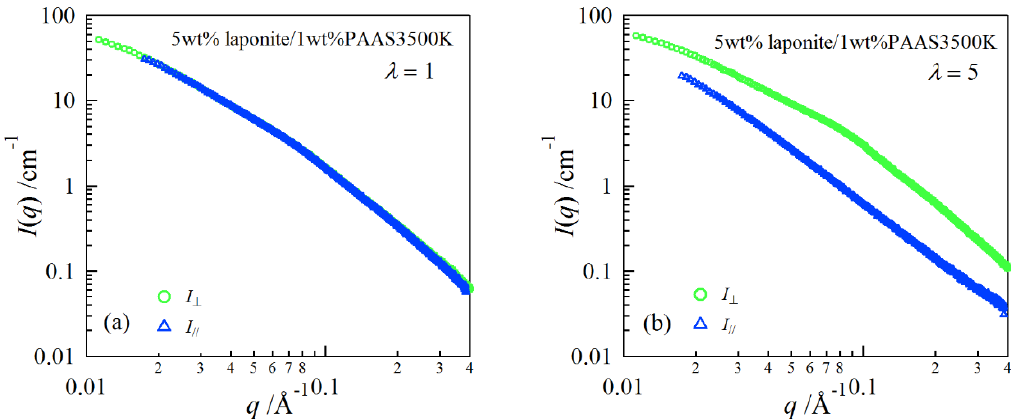
Figure 8. SAXS profiles in the directions parallel and perpendicular to the stretching for a 5 wt % laponite/PAAS gel at the elongation ratio of 1 ( a ) and 5 ( b ).